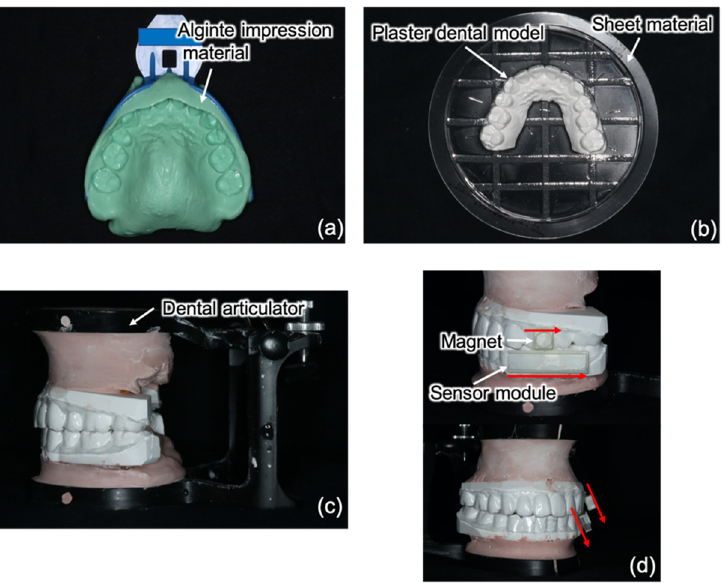
Figure 7. Manufacturing procedures of the mouthpiece-type mandibular movement-measuring device. ( a ) Impressions of the teeth are obtained; ( b ) the mouthpiece sheet material is attached; ( c ) the dental models are attached to the dental articulator; ( d ) the magnet and sensor module are installed parallel to each other.